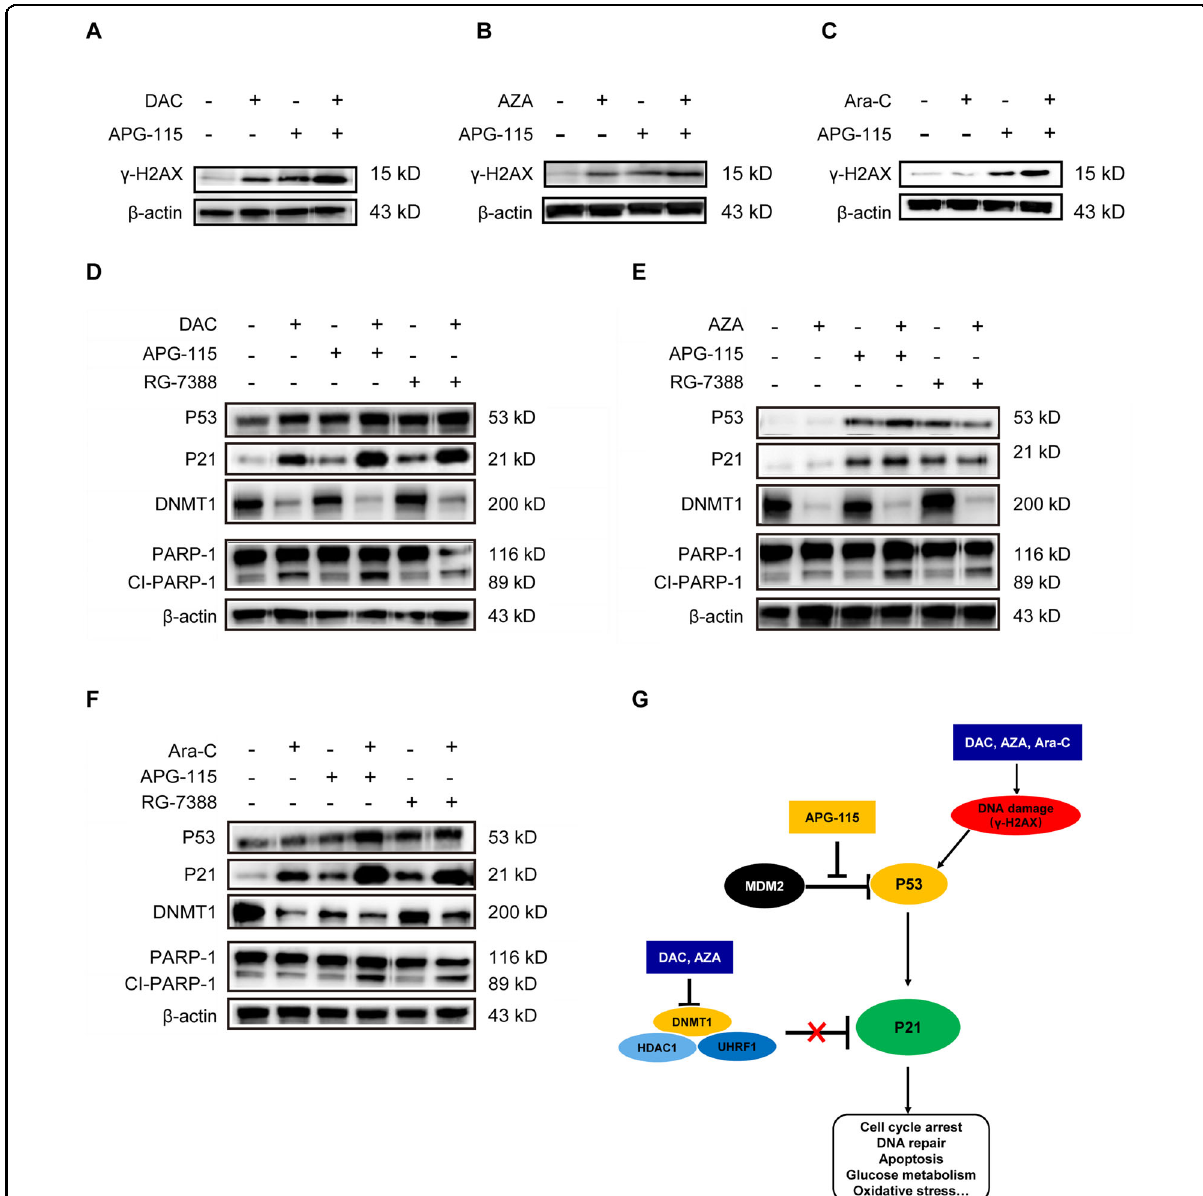
Fig. 6 Combined treatment with APG-115 and AZA, DAC, or Ara-C coordinately induces DNA damage and activates the P53/P21 pathway in AML cells. A , B MOLM-13 cells were treated with DAC (100 nM) or AZA (0.33 µM) for 24 h and then refreshed with DAC or AZA combined with APG-115 (40 nM) for an additional 24 h. Expression levels of γ -H2AX, a biomarker for DNA double-strand breaks, were assessed by Western blot. C Expression levels of γ -H2AX in MOLM-13 cells treated with Ara-C (100 nM) alone or in combination with APG-115 (40 nM) for 48 h. D – F Protein expression in MOLM-13 cells treated with APG-115 (40 nM), AZA (3 µM), Ara-C (100 nM), DAC (100nM), or RG-7388 (40 nM), or their combinations as indicated for 48 h ( D , F ) or 6 h ( E ). β -actin was included as a loading control. Representative results from three independent experiments. G Proposed mechanism of action of APG-115 in combination with AZA, DAC, or Ara-C in AML cells. Cl-PARP-1, cleaved poly (ADP ‒ ribose) polymerase-1; DNMT1, DNA methyltransferase inhibitor; HDAC, histone deacetylase; γ - H2AX, H2A histone family member X; UHRF1, ubiquitin-like with PHD and RING fi nger domains